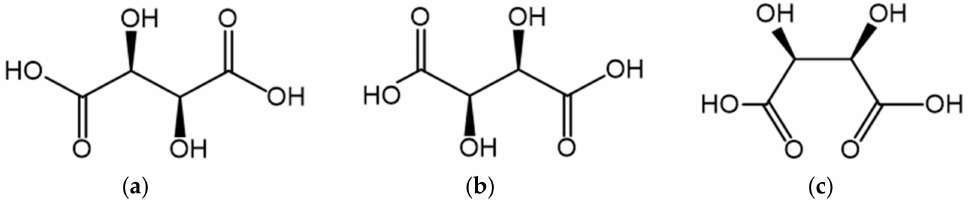
Figure 1. Formulae of tartaric acid: ( a ) Enantiomer L-( + ); ( b ) enantiomer D-(-); ( c ) meso form.